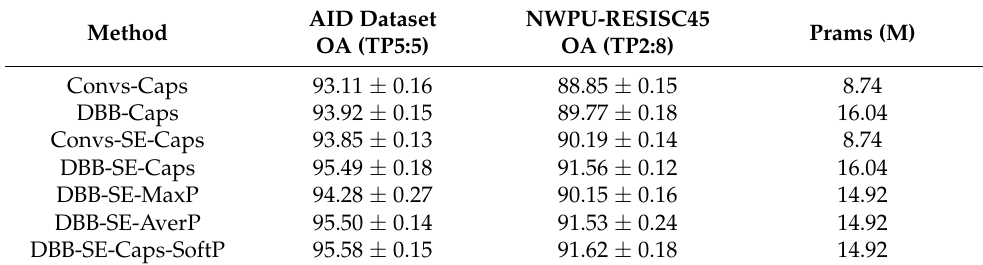
Table 4. Ablation test results of the proposed